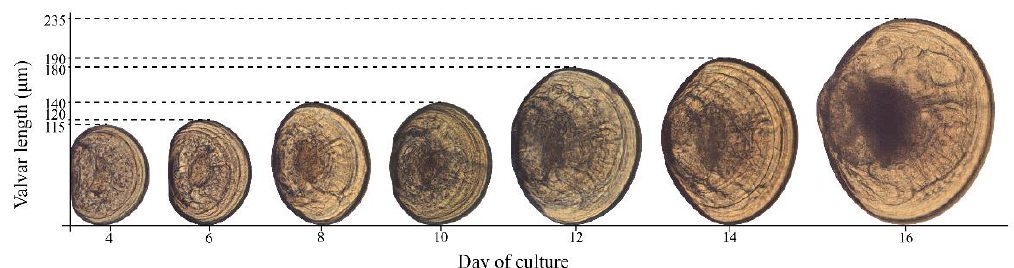
Figure 4. Larval development of the surf clam Mesodesma donacium maintained at 16 °C. The size of the larvae is shown from day 4 to day 16 post fertilization: D larva from day 4 to 10 and umbonate larva from day 12 to 16.